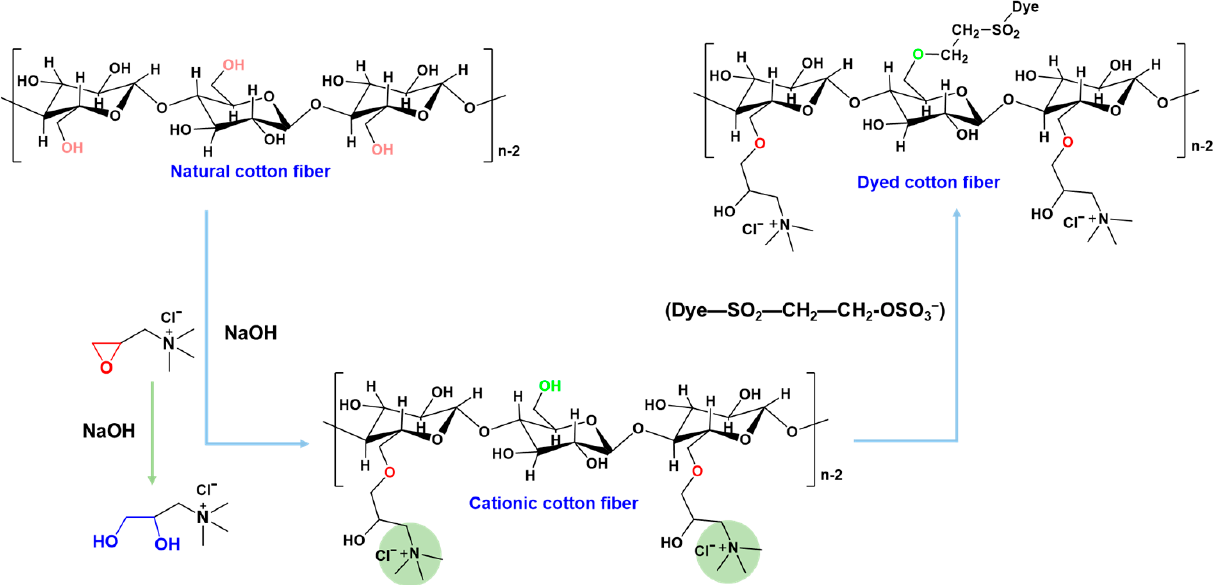
Figure 1. Schematic diagram of the reaction mechanism of GTA with natural cotton fiber and the reaction of reactive dye with the cationic cotton fiber.